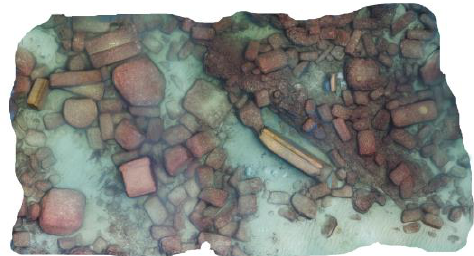
Figure 5. Spring of 2014, first orthophoto of 750 m 2 composed of 1322 images (photography by Mohamed Elsayed, data processing by Mohamed Abdelaziz)